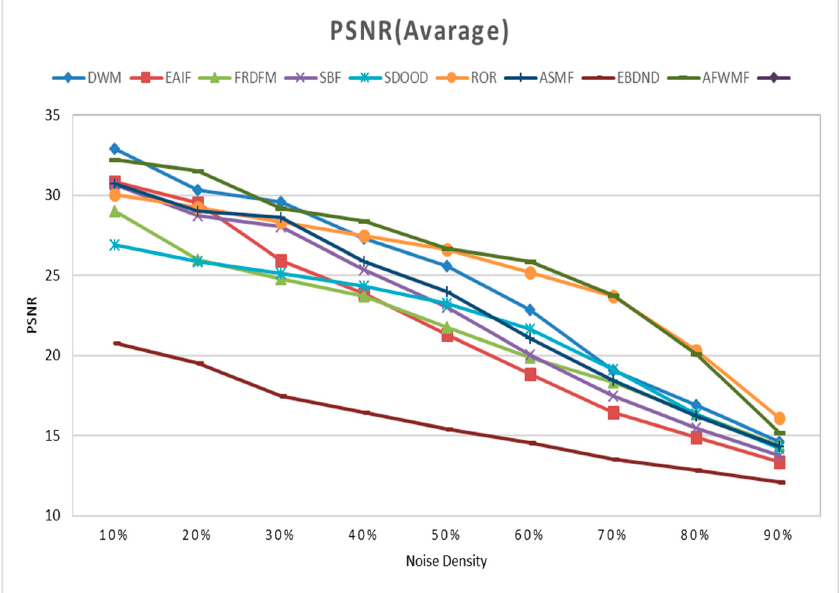
Figure 12. Performance of the PSNR average value for the five experimental images at different random values of pulse noise density. Table 5. The best filter model at different noise densities in the PSNR average value for the five experimental images. Ratio\Image